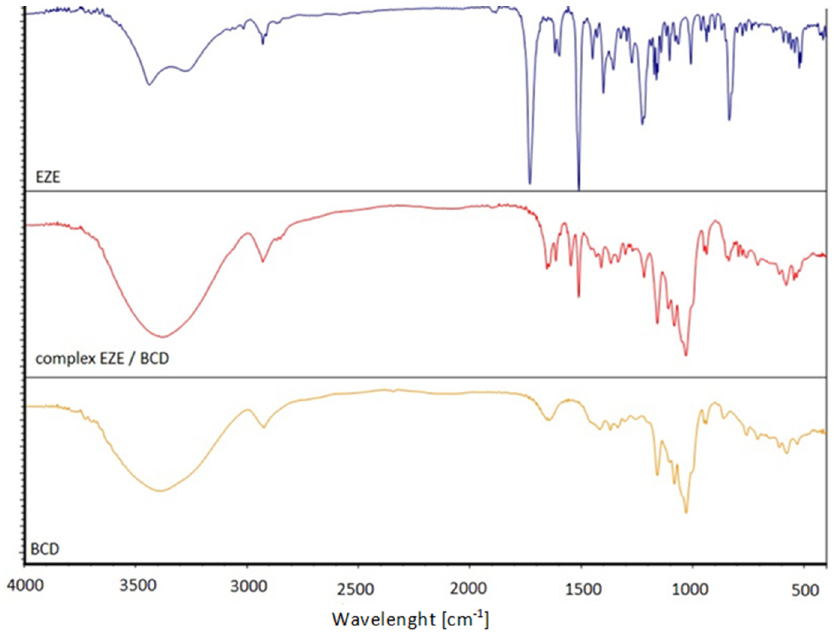
Figure 7. FTIR spectra of ezetimibe (EZE), β -cyclodextrin ( β CD) and ezetimibe/ β -cyclodextrin com- plex (complex EZE/ β CD). complex (complex EZE/ β